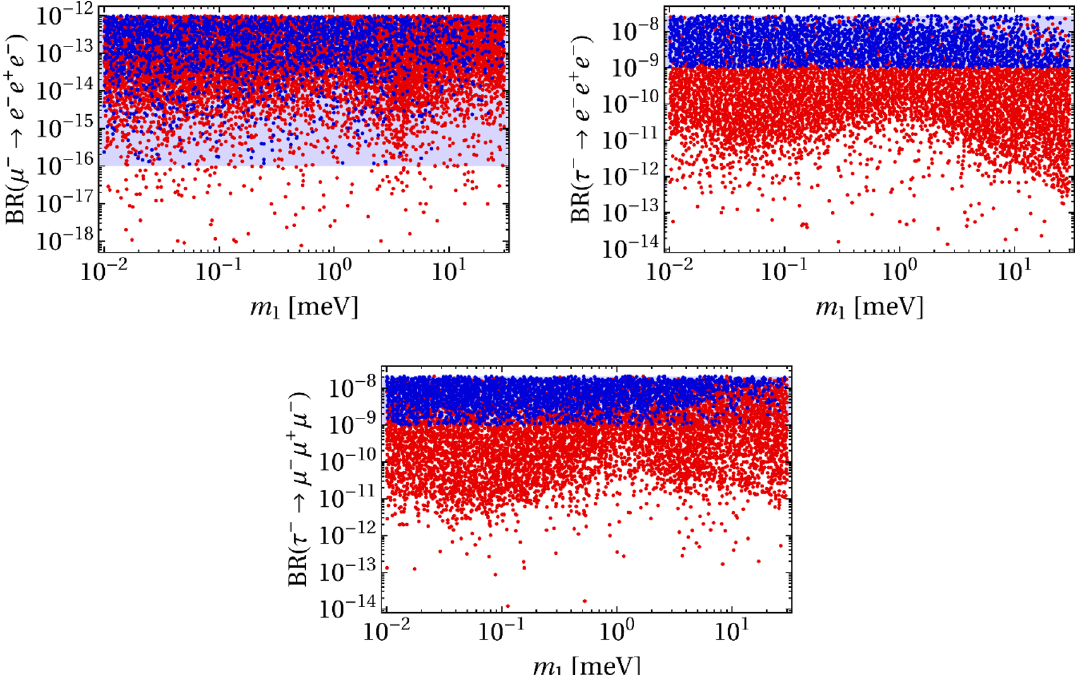
Figure 4 . Scatter plots of BR ( µ − → e − e + e − ) (top-left panel), BR ( τ − → e − e + e − ) (top-right panel), and BR ( τ − → µ − µ + µ − ) (bottom panel) as functions of the lightest-neutrino mass m 1 ; the other inputs are given in (5.1) and (5.2). In all the displayed points, all five BRs satisfy the present experimental bounds given in table 1. Blue points have all five BRs larger than the expected future sensitivities, while red points allow one or more (but not all) BRs to be below the future sensitivities. The shadowed bands show the ranges between the present experimental bounds and the future experimental sensitivities, viz. 10 − 16 for BR ( µ − → e − e + e − ) and 10 − 9 for the BRs of the τ −